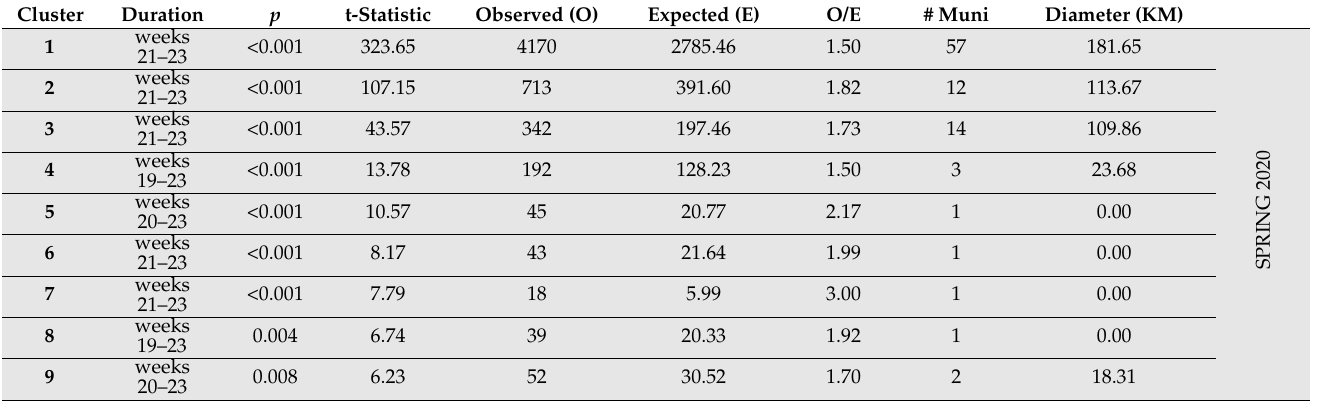
Table 1. Characteristics of the prospective spatiotemporal clusters (weeks